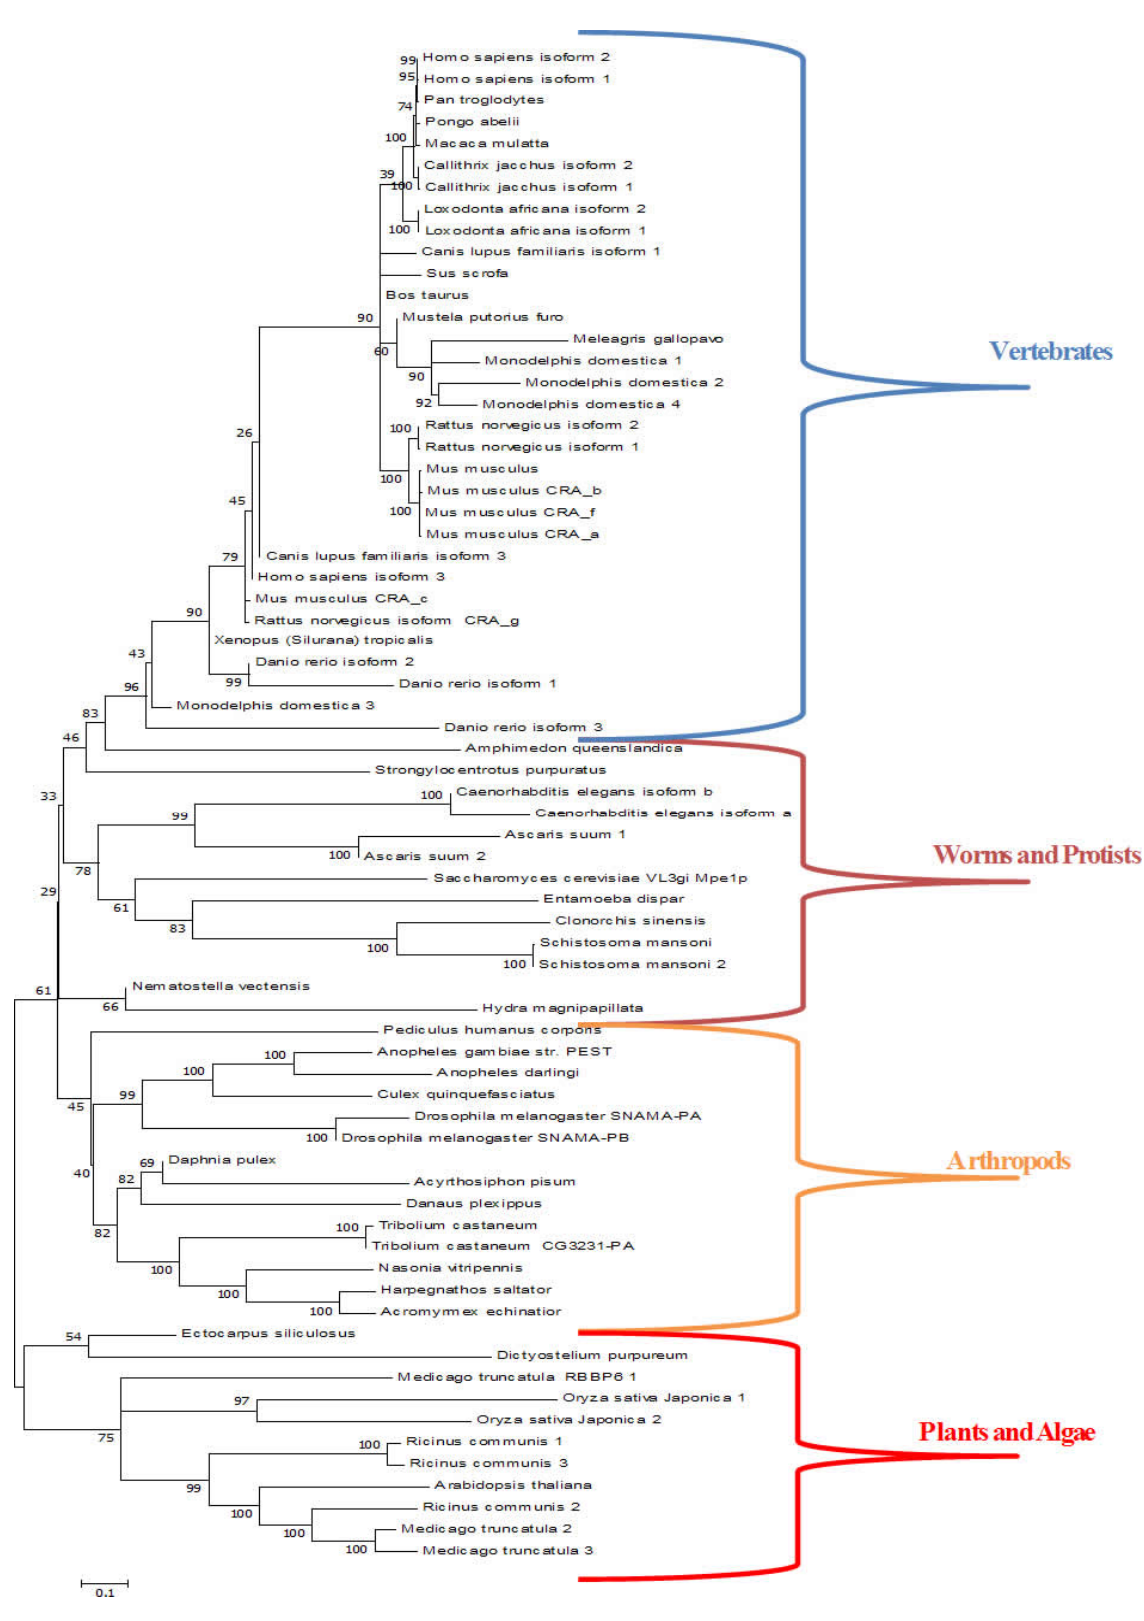
Figure 3. Phylogenetic analysis of proteins with DWNN domains. Full RBBP6 orthologous protein sequences were aligned in MEGA 5, using the default ClustalW algorithm. The multiple sequence alignment was then analyzed and tweaked manually to ensure important conserved residues (lysines, di-glycine motif) were accurately